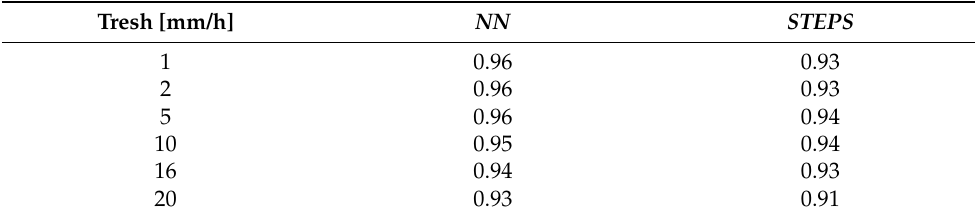
Table 3. Area under the ROC AUC curve for NN and STEPS for exceeding different cumulative precipitation thresholds in the first hour of the